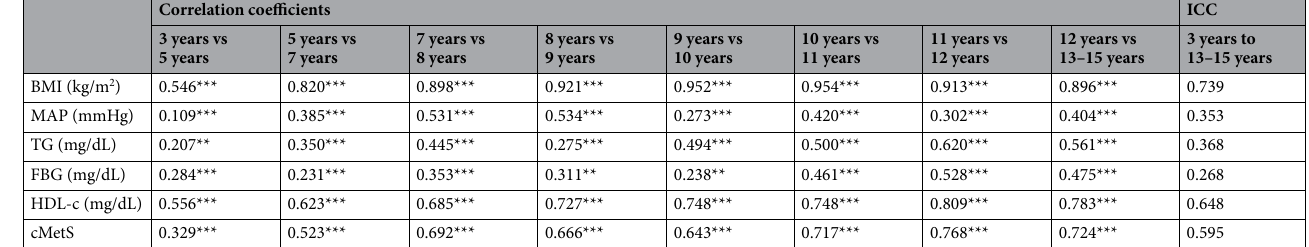
Table 2. Correlation between repeated measurements of metabolic syndrome components at different times and ICC. BMI, body mass index; MAP, mean arterial pressure; TG, triglyceride; FG, fasting blood glucose; HDL-c, high-density lipoprotein-cholesterol; ICC, Intra-class correlation, cMetS, continuous metabolic syndrome score. * < 0.05, ** < 0.01, *** <